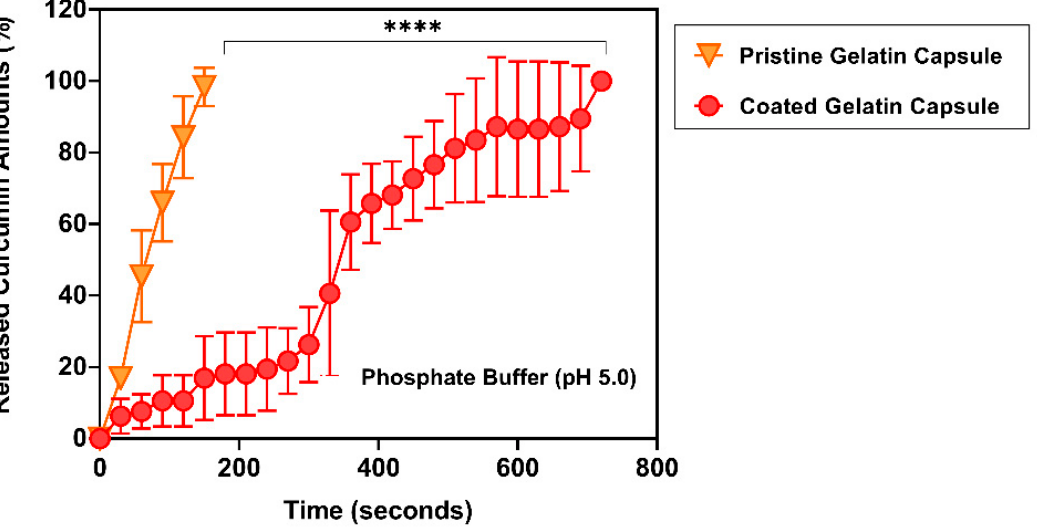
Figure 6. Accumulated curcumin release profiles from different gelatin capsules over time at pH 5.0. Significantly delayed release of curcumin over 12 minutes (720 s) was observed from EA doped enteric-coated gelatin capsules (n = 3 in each condition). ****: p < 0.0001.